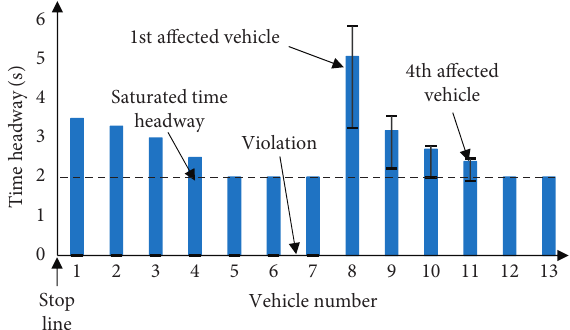
Figure 4: Time headway after violations (with the first and third